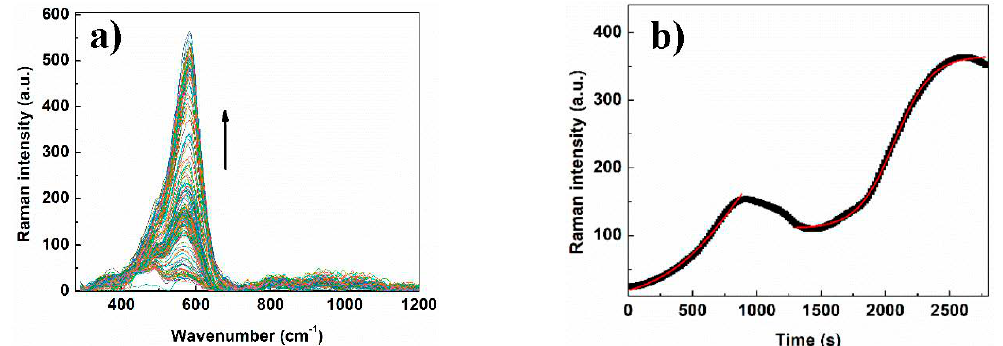
Figure 7. ( a ) Time-dependent Raman spectrum of Cr (III) + EDTA in the presence of Cit-AgNPs at pH = 9.6. ( b ) plotting and fitting the maximum of Raman intensity versus time by using Prout–Tompkins equation. First adjustment between 0 and 1000 s, k = 0.18 min − 1 , Adj. R-squared 0.995. Second one between 1300 s and 2750 s, k = 0.42 min − 1 , Adj. R-squared 0.999.